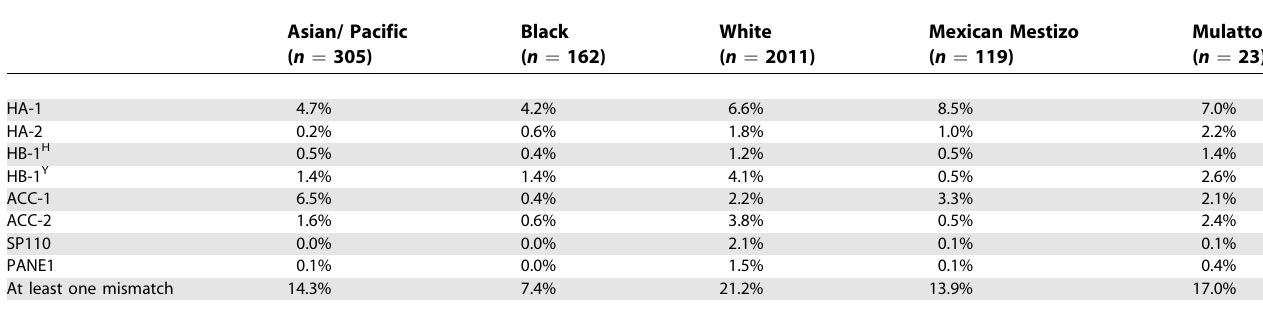
Table 5. Estimated Disparity Rates for Hematopoietic Minor H Antigens in HLA-Matched Transplant Sib Pairs Corrected for the Frequencies of the HLA Restriction Molecule